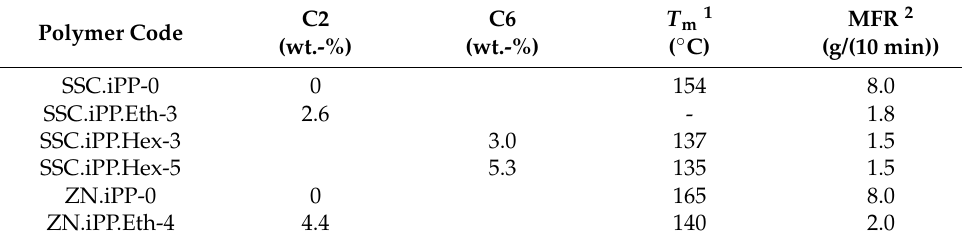
Table 1. Molecular characteristics of the non-nucleated samples of the present study. Polymer Code